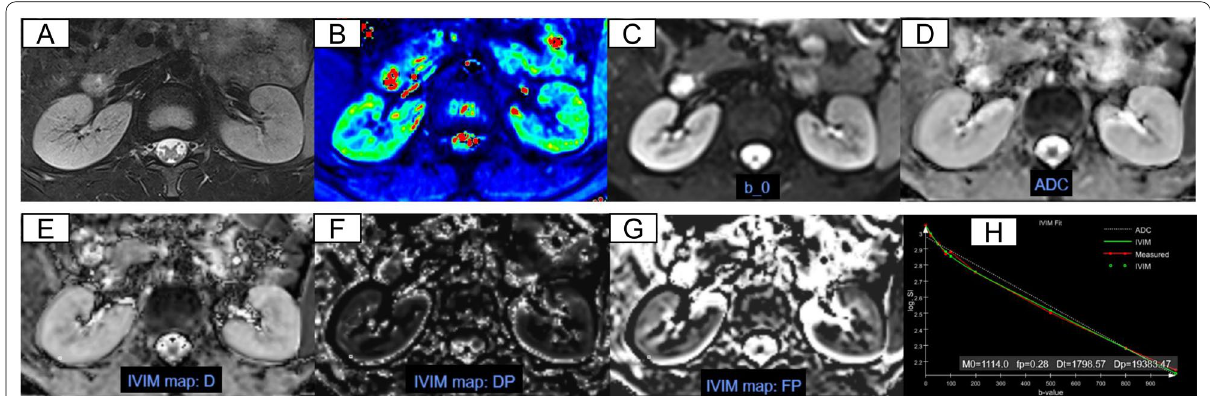
Fig. 2 Respective MRI images of healthy volunteers (12 years old, male). A – H axial T2-weighted images, T2* mapping, b0 map, ADC, D t , D p , f p , IVIM fit, respectively